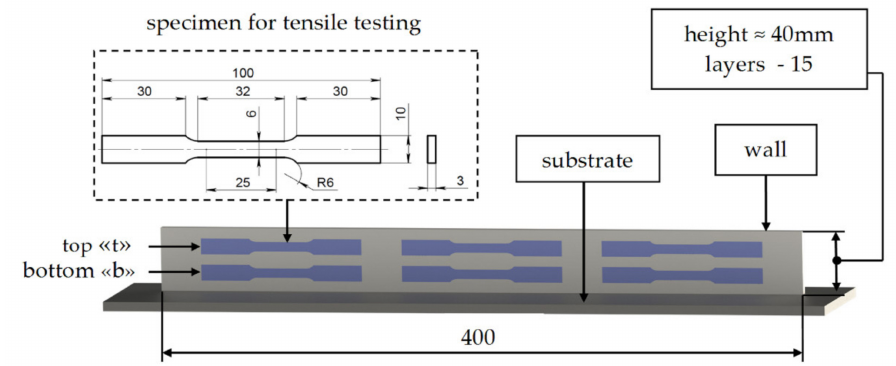
Figure 5. Specimens location in wall and one’s dimensions (all dimensions are in